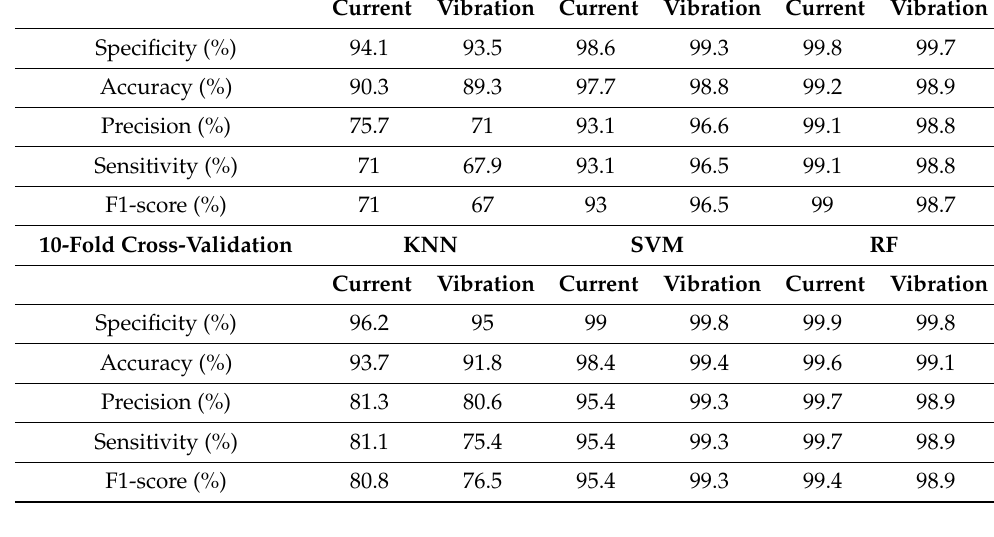
99 Table 8. Classification results applying genetic algorithm. 5-Fold Cross-Validation